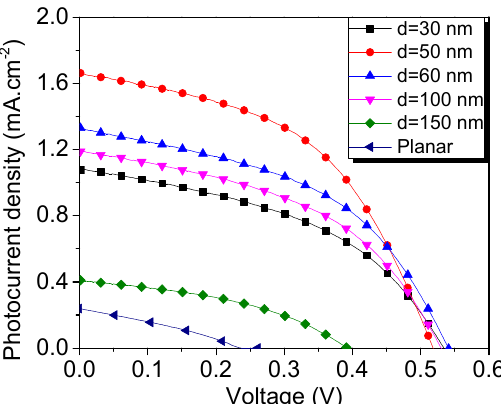
Figure 4. Volt-ampere characteristics of Si/GaN NW/P3HT:PC 71 BM ordered bulk heterostructures with di ff erent average nanowire diameters under AM1.5 illumination. Red circles represent the most